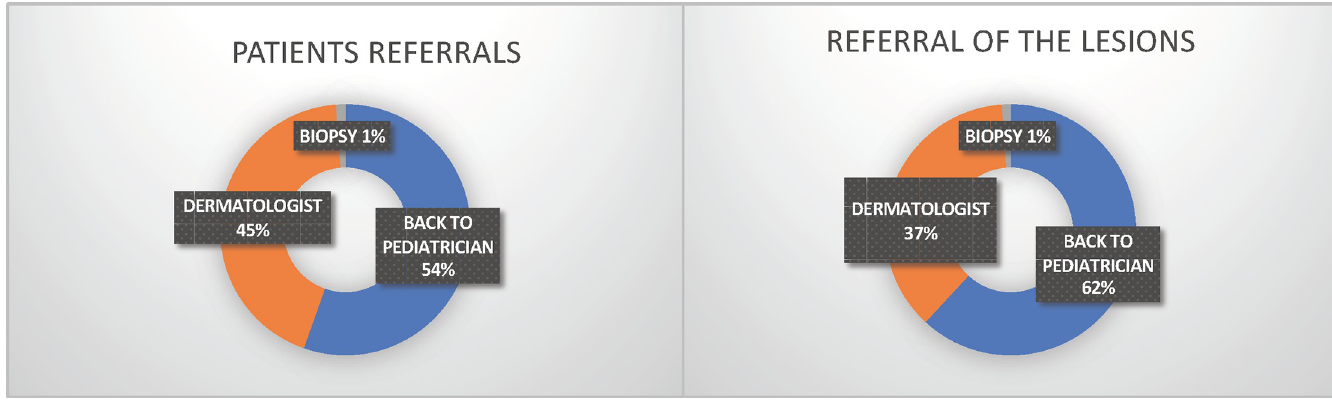
Fig 1. Distribution of the lesions and the patients 0–19 years old who participated in the Teledermatology Project referred to biopsy, dermatologist and back to pediatrician according to age and sex, from July 2017-July 2018, in the city of S ã o Paulo.